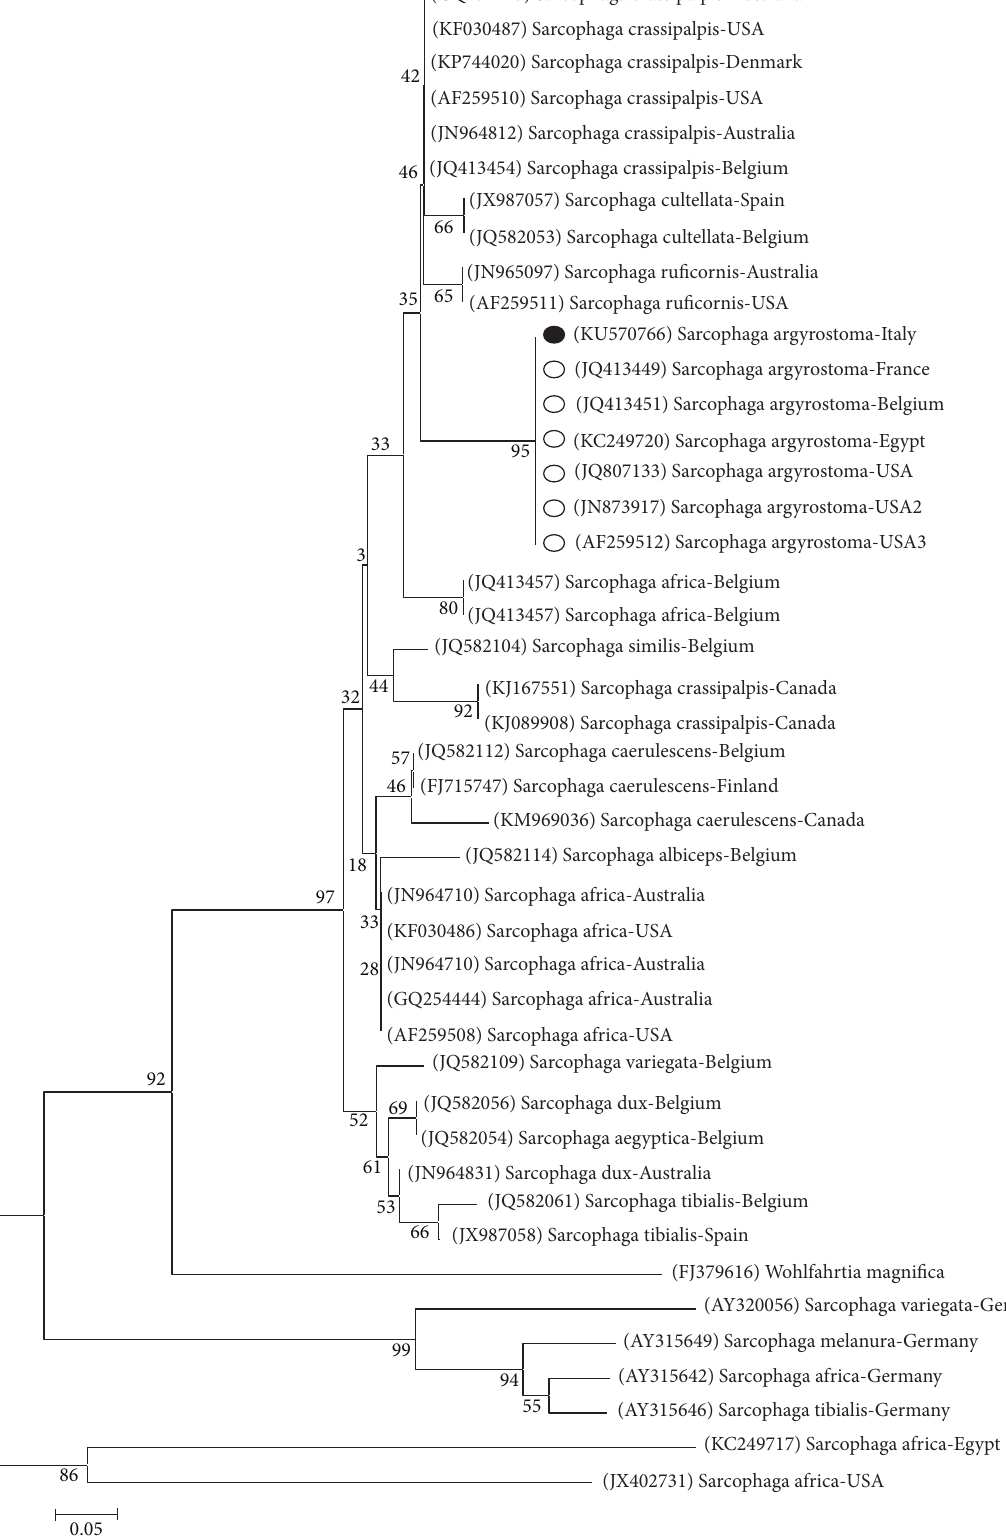
Figure 5: The Neighbor-Joining (NJ) phylogenetic tree based on analysis of the partial cytochrome 𝑐 oxidase subunit I gene of Sarcophaga species of forensic interest. The Sarcophaga argyrostoma sequence from the present study (black spot), 11 sequences representing the other Sarcophaga species belonging to Liopygia subgenus, that is, S. crassipalpis (9) and S. cultellata (2) and 20 other Sarcophaga species from GenBank were included in the analysis for comparative purposes. Wohlfahrtia magnifica was used as an outgroup. GenBank accession numbers (in brackets), Sarcophaga species, and country of origin are